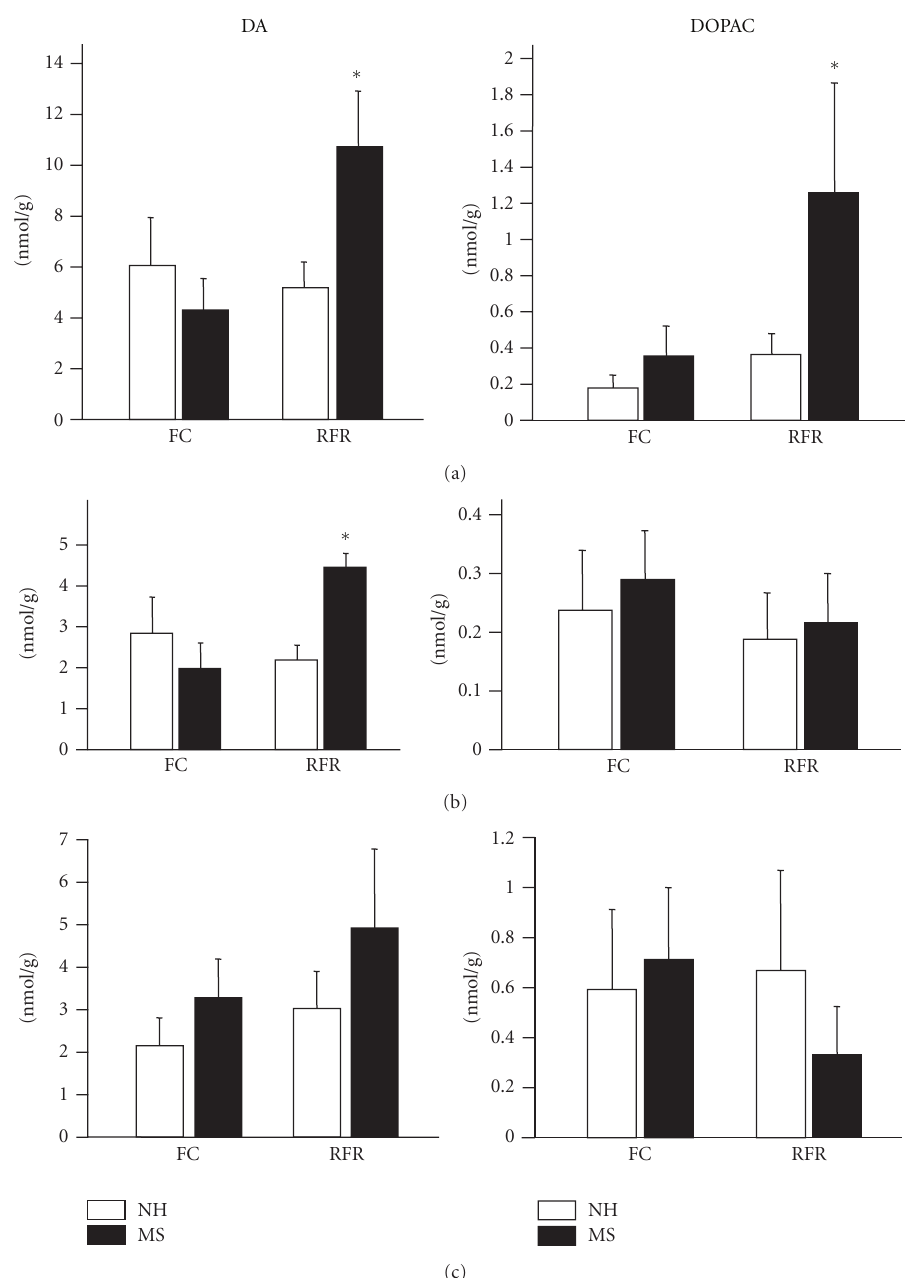
Figure 4: Tissue contents of dopamine (DA) and dihydroxyphenylacetic acid (DOPAC) in the hippocampus (a), the ventral tegmental area and substantia nigra (b), and the nucleus accumbens (c). After the 21st refeeding session (PND 70), rats were rapidly decapitated, and the tissue contents of DA and DOPAC were analyzed by high-performance liquid chromatography. ∗ P < 0.05 versus MS/FC, NH: nonhandled, MS: maternal separation, FC: free fed control, RFR: repeated fasting/refeeding. Data are presented as means ±